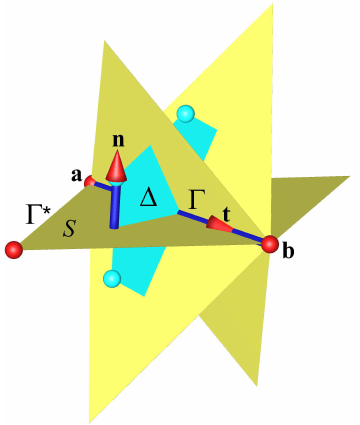
Figure 1. Discrete geometric structure: a set of primitive planar facets S are associated with the segment Γ of unit vector t whose ends a and b are distant by a length d . Each facet is defined by a contour Γ ∗ , a collection of three segments Γ , is oriented according to the normal n such that n · t = 0; the dual surface ∆ connecting the centroids of the cells is also